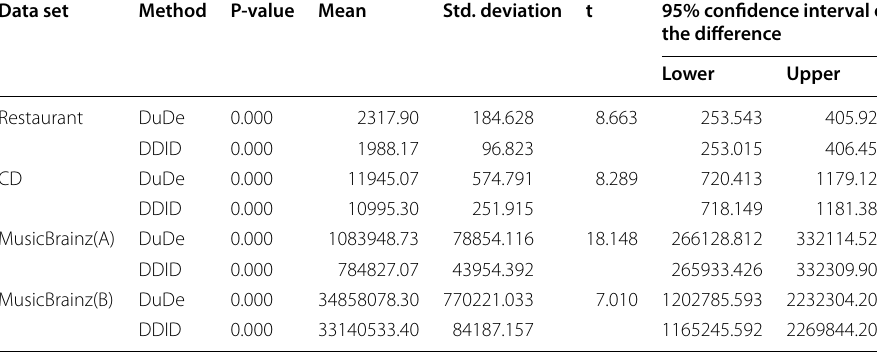
Table 4 Independent samples T -test for elapsed time Data